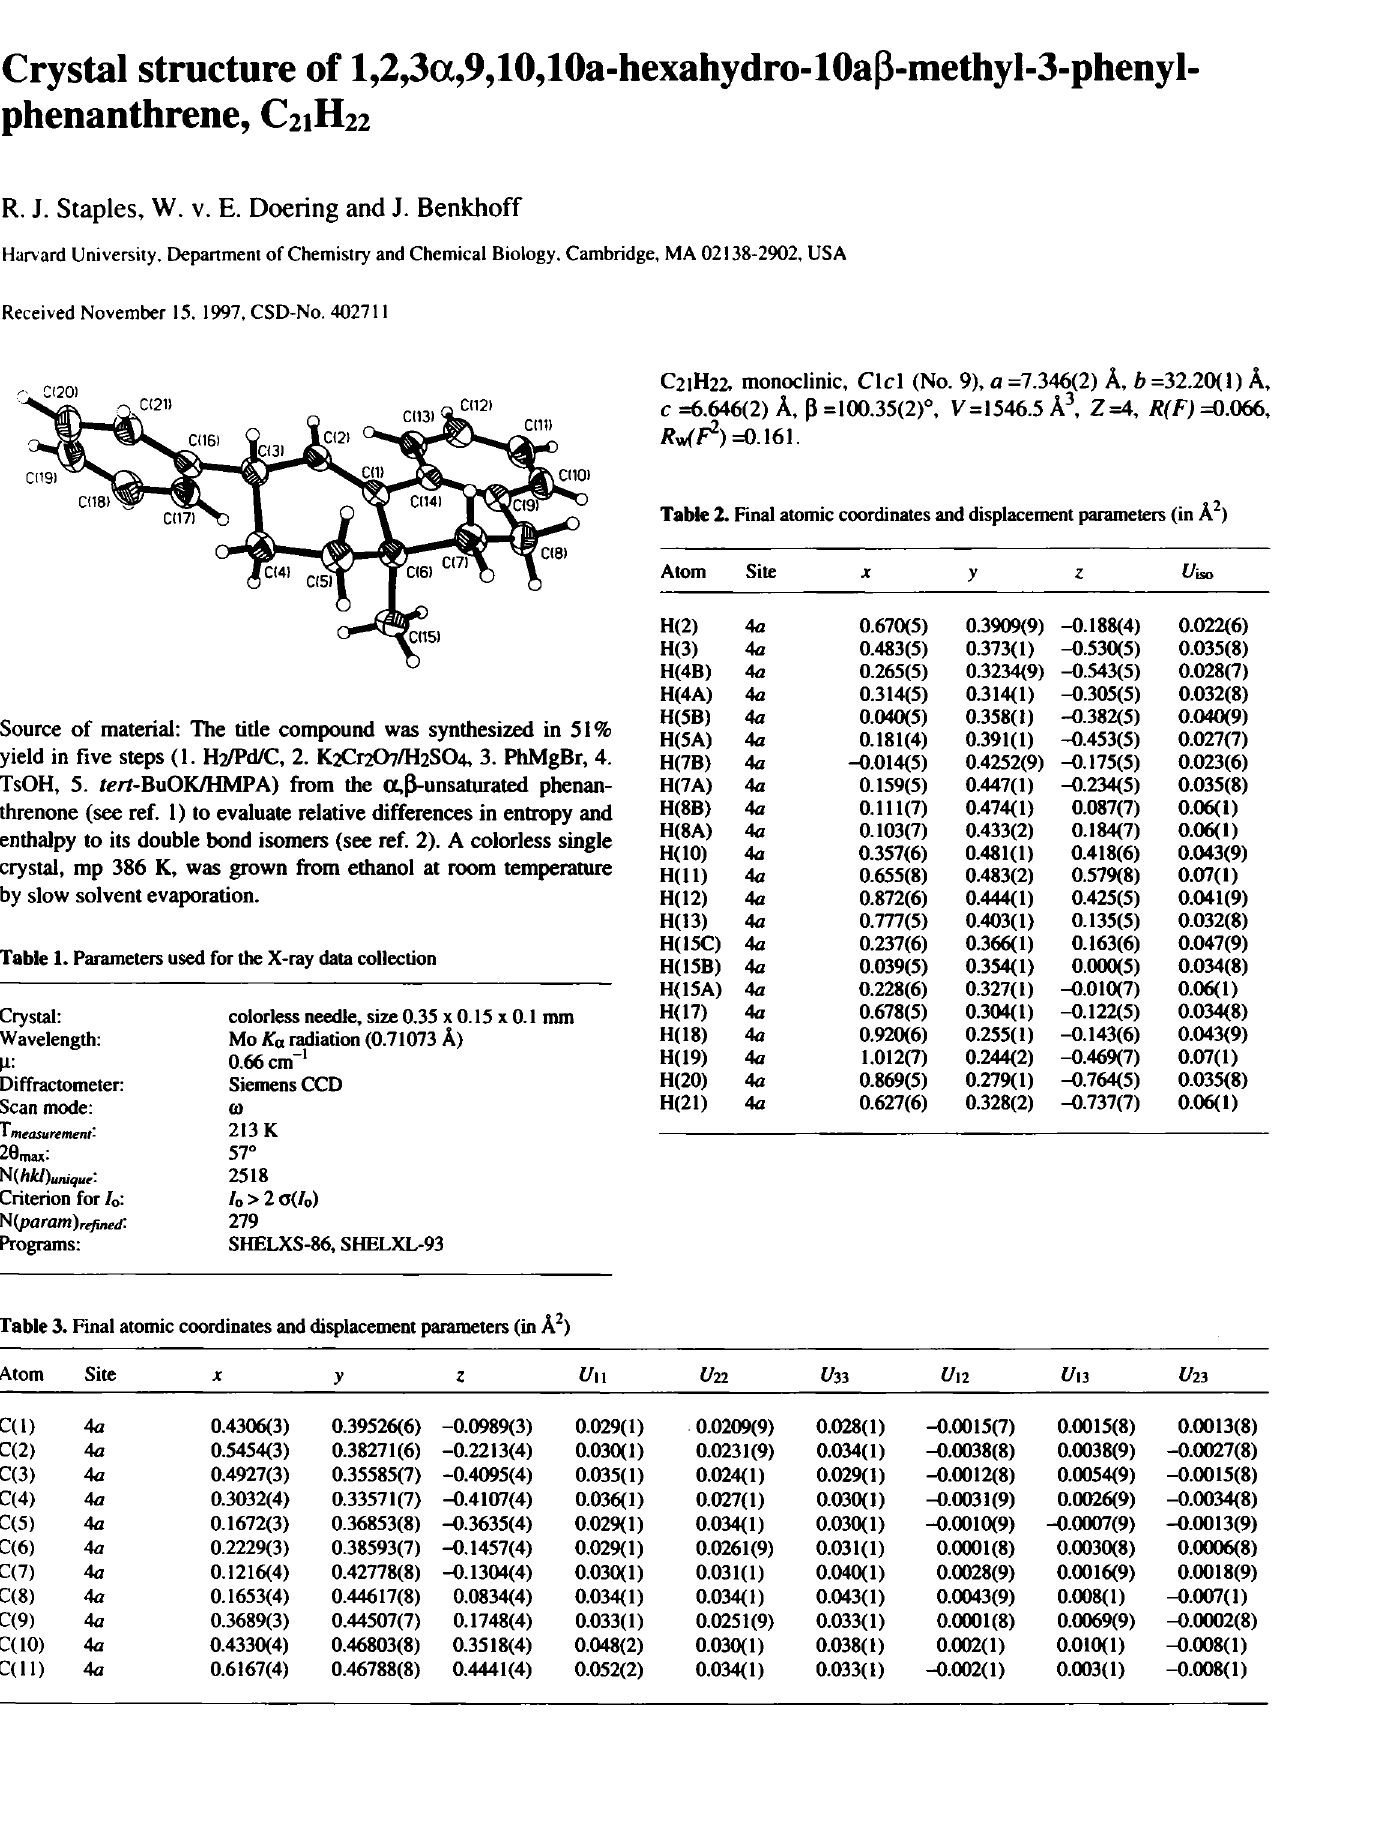
Table 2. Final atomic coordinates and displacement parameters (in A 2 )